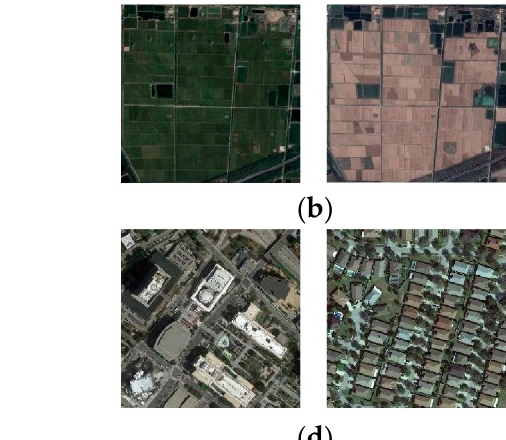
Figure 1. Image characteristics of geographic scenes in HSR remote sensing: ( a ) reflects the diversity of the ground objects in the geographic scene; ( b ) reflects the diversity of imaging conditions of HSR remote sensing images; ( c ) reflects the differences in the types of ground objects in the same category of geographic scenes; ( d ) reflects the similarity in the types of ground objects in different categories of geographic scenes.